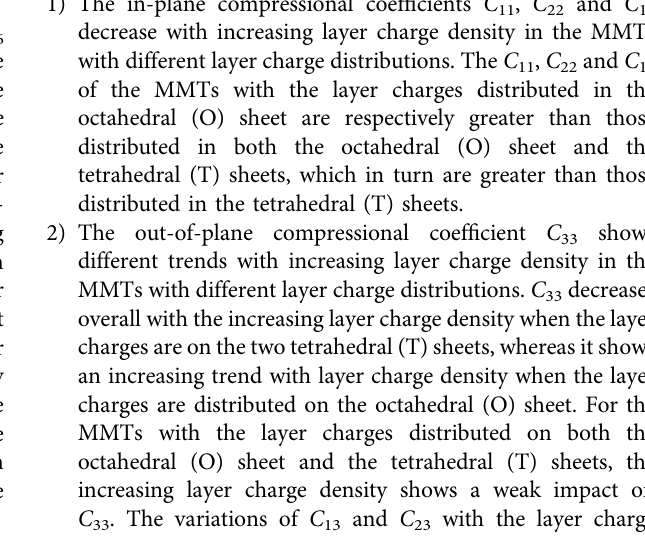
Frontiers in Earth Science |